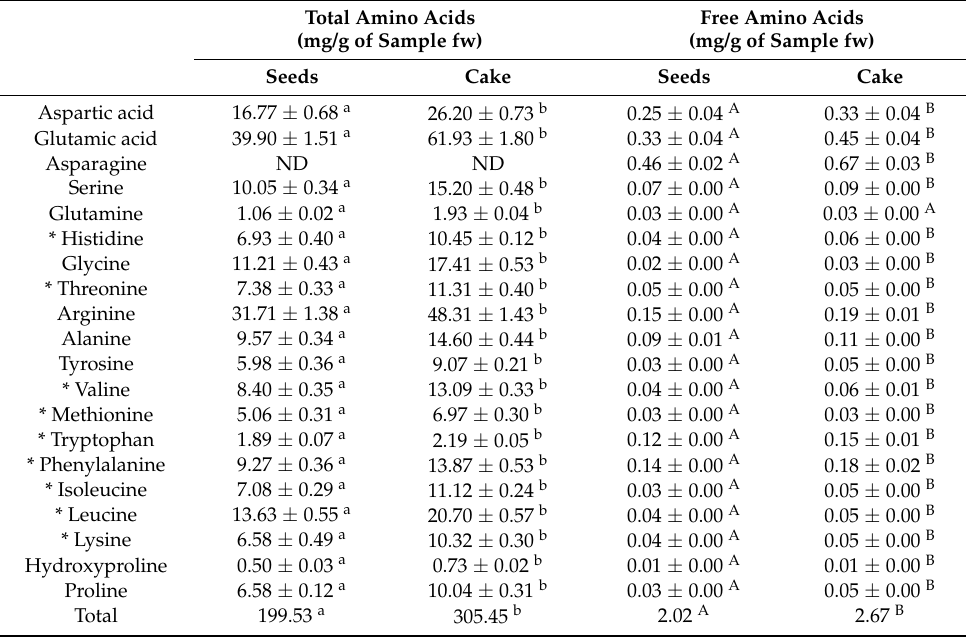
Table 2. Amino acids profile of sesame seeds and cake. Total Amino Acids (mg/g of Sample